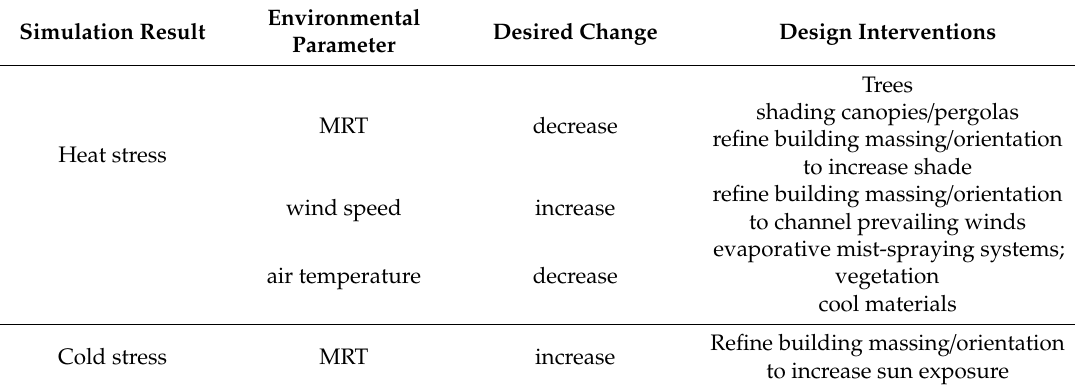
Table 2. Simulation results and corresponding design